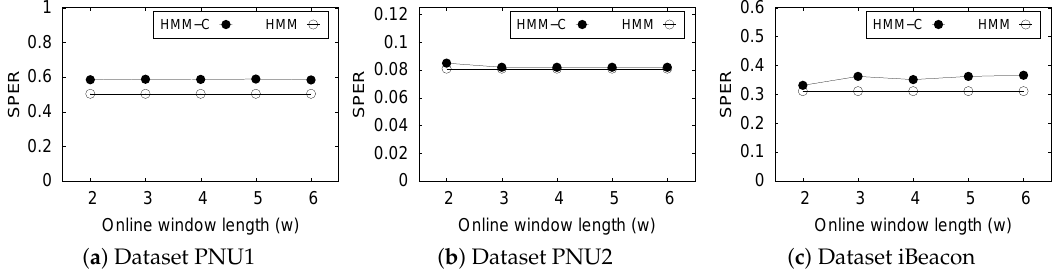
Figure 10. Performance of Hidden Markov Model (HMM) and that with constraints (HMM-C) with various window